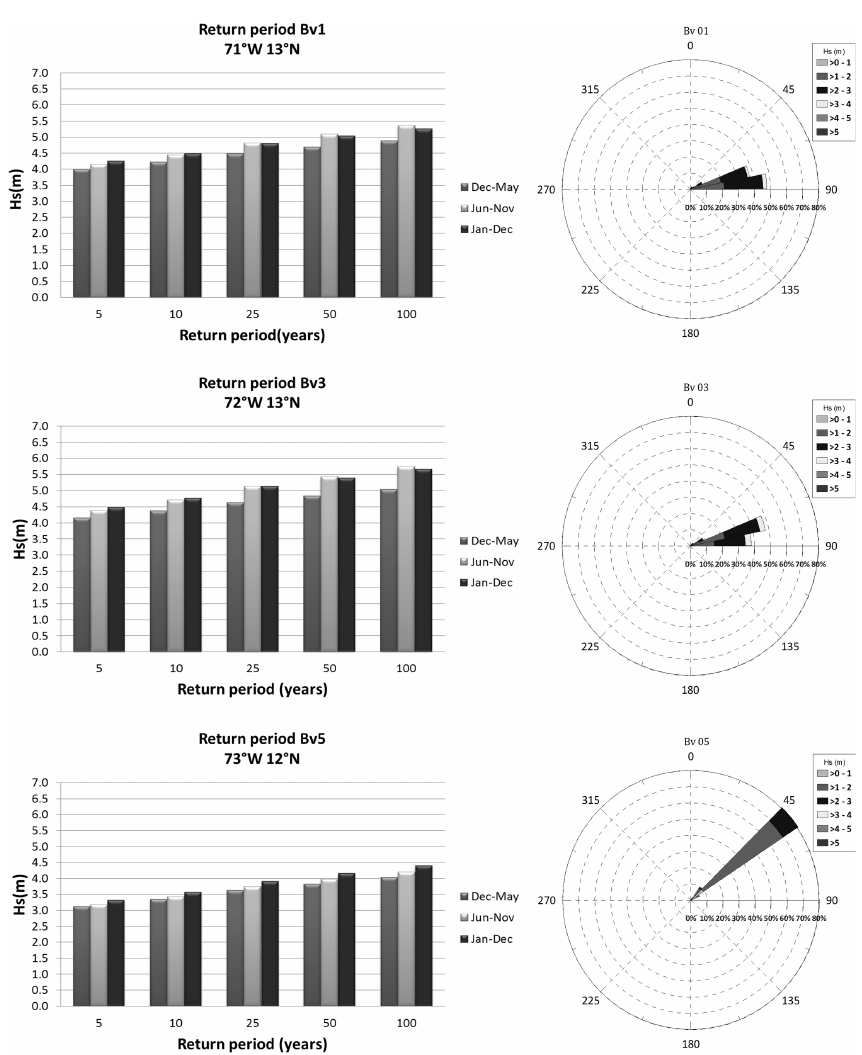
Figure 4. Return periods for H s of virtual buoys BV01–BV05 (zone